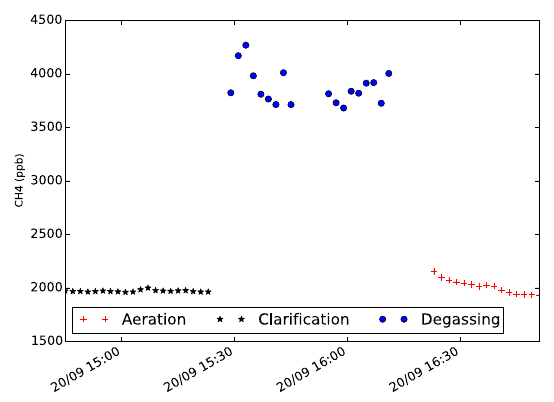
Figure 9. CH 4 concentrations measured by the LSCE FTIR ana- lyzer over the different